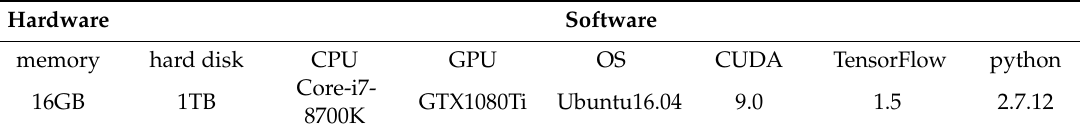
Table 1. Platform